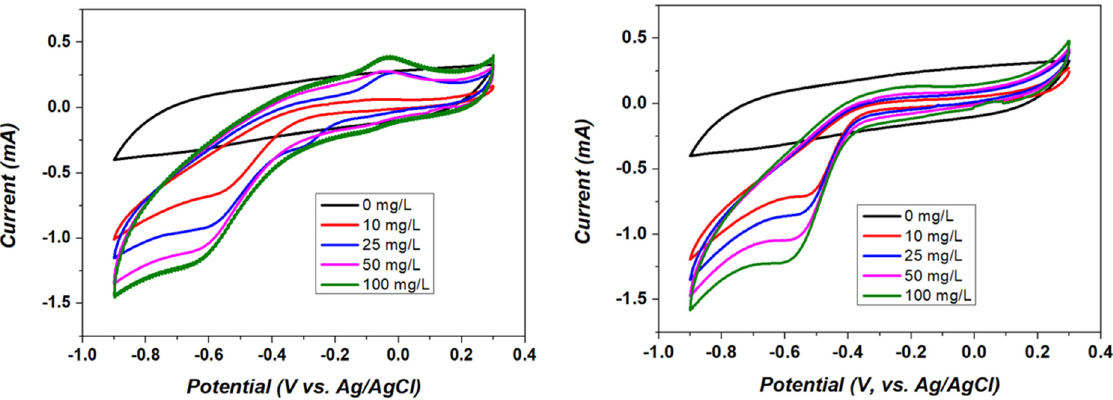
Figure 7. CV tests performed for redox reactions at different concentrations of NO 2 − -N and NO 3 − -N.